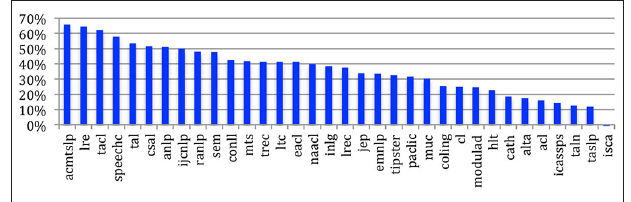
FIGURE 20 | Author redundancy across the sources.